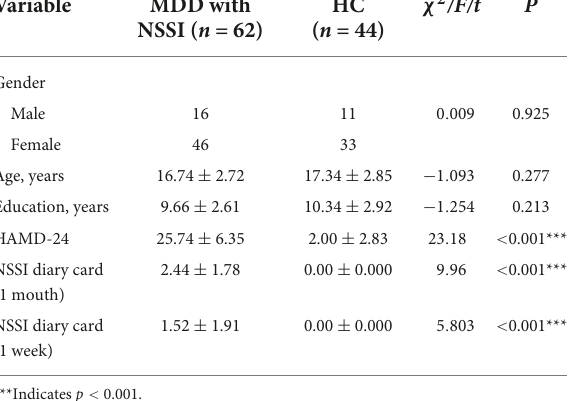
TABLE 1 Demographic and clinical of all participants.